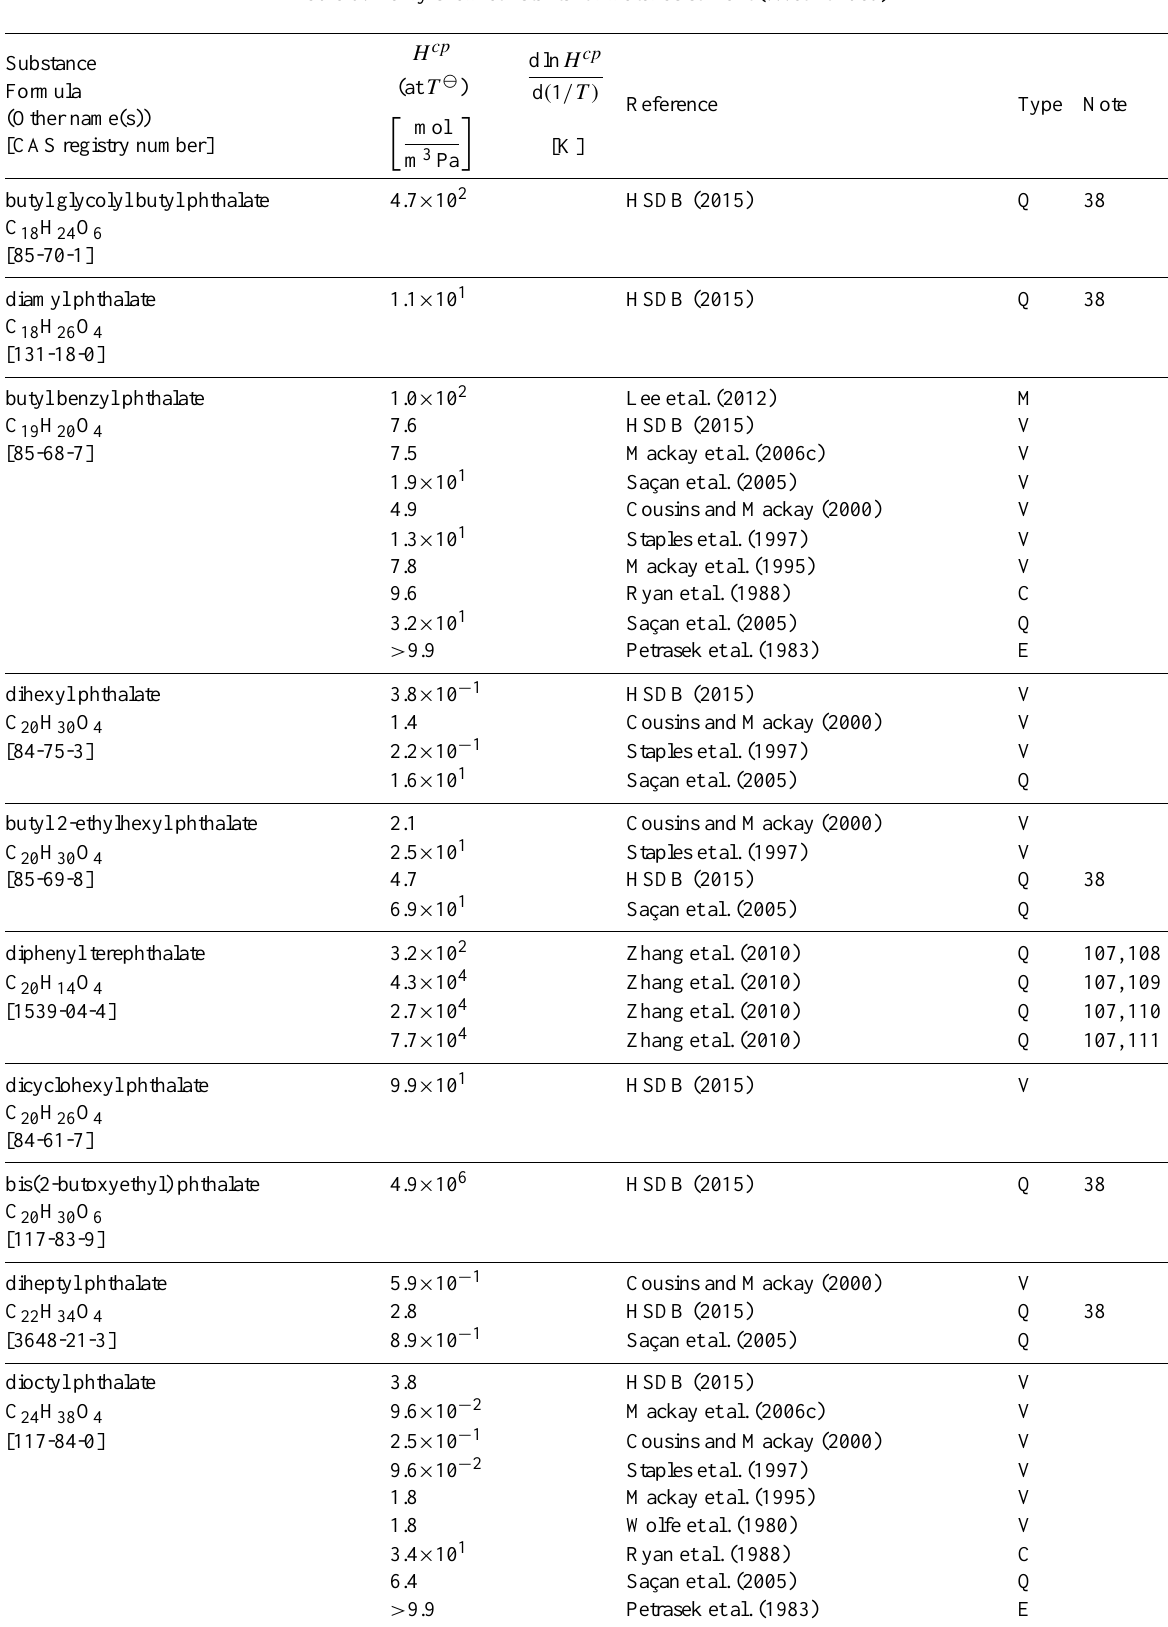
Table 6: Henry’s law constants for water as solvent